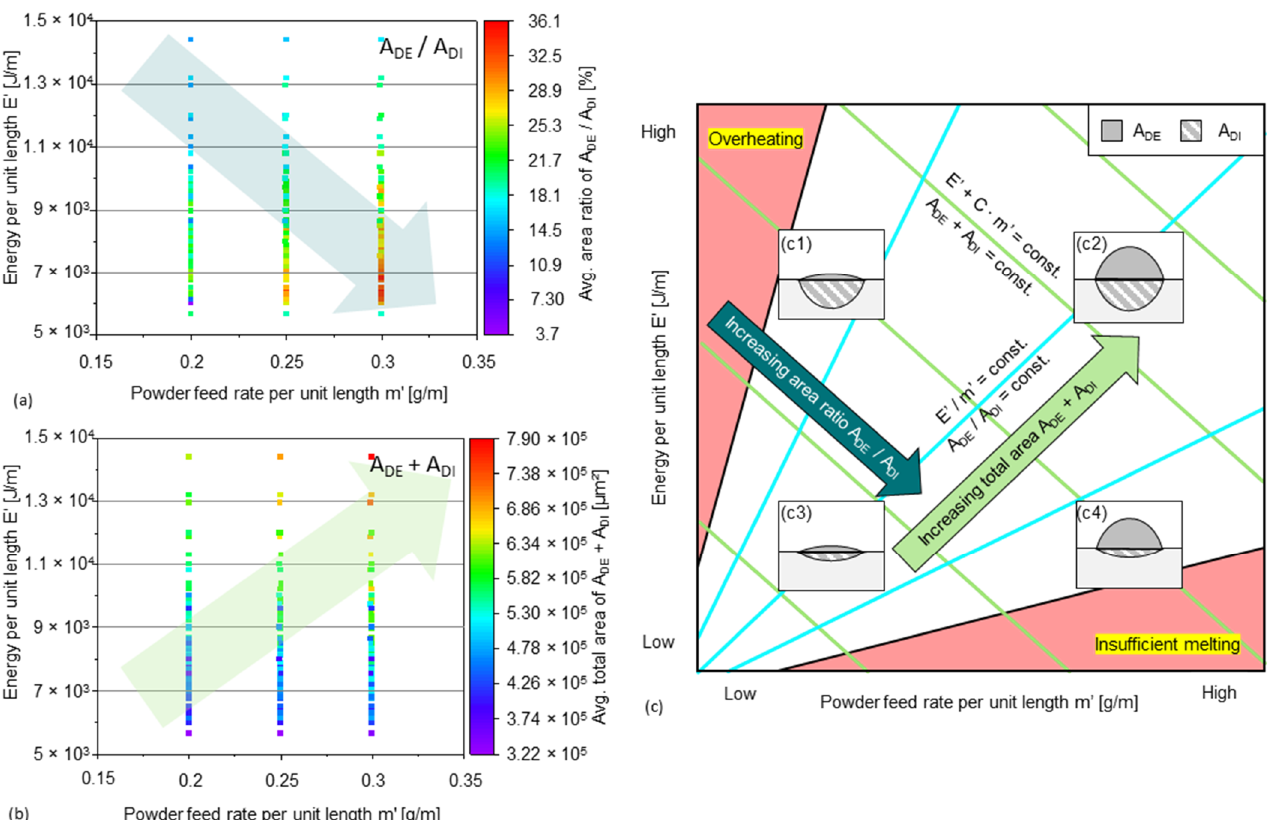
Figure 12. The influence of E’ and m’ on ( a ) A DE / A DI and ( b ) A DE + A DI represented by real data and by ( c ) a schematic diagram where the subfigures represent four different area ratios.